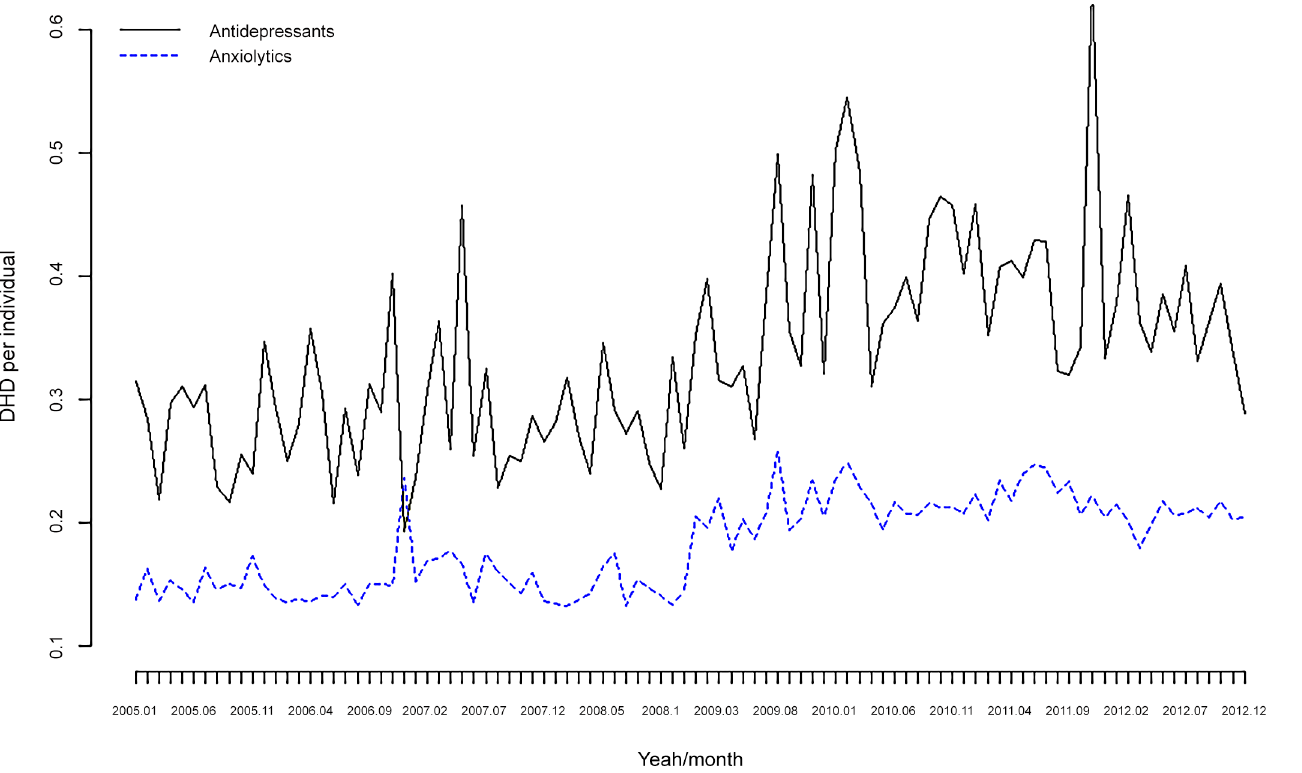
Fig 4. Consumption of psychotropic drugs. Antidepressants and anxiolytics. DDD per individual/month. Monthly data for the period 2005 –